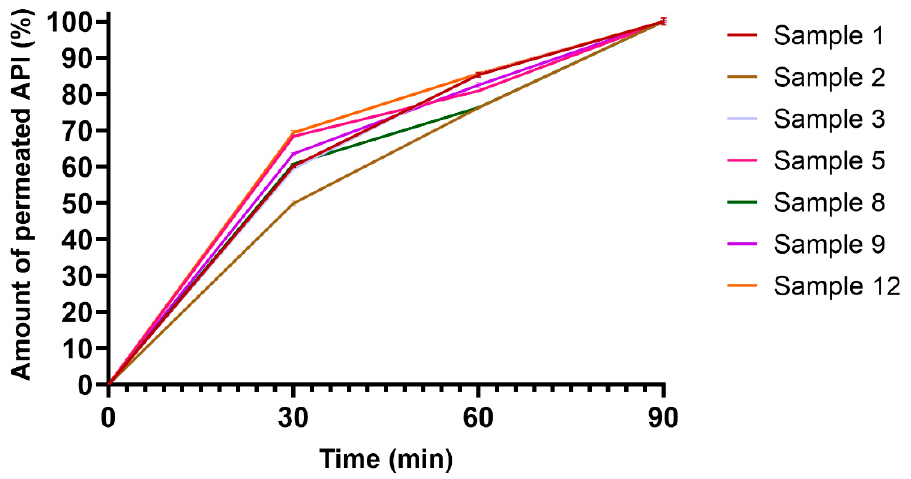
Figure 7. Transported CTZ–time curves of buccal films on the TR-146 cell line. Each film was investigated in three separate, parallel cell culture inserts (Samples 2, 8, 12 contain CA) ( n = 3) .